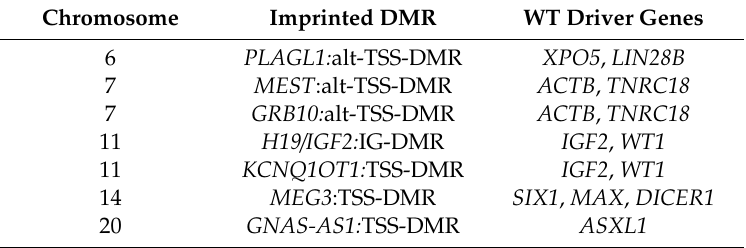
Table 1. WTs driver genes flanking the indicated imprinted DMRs.